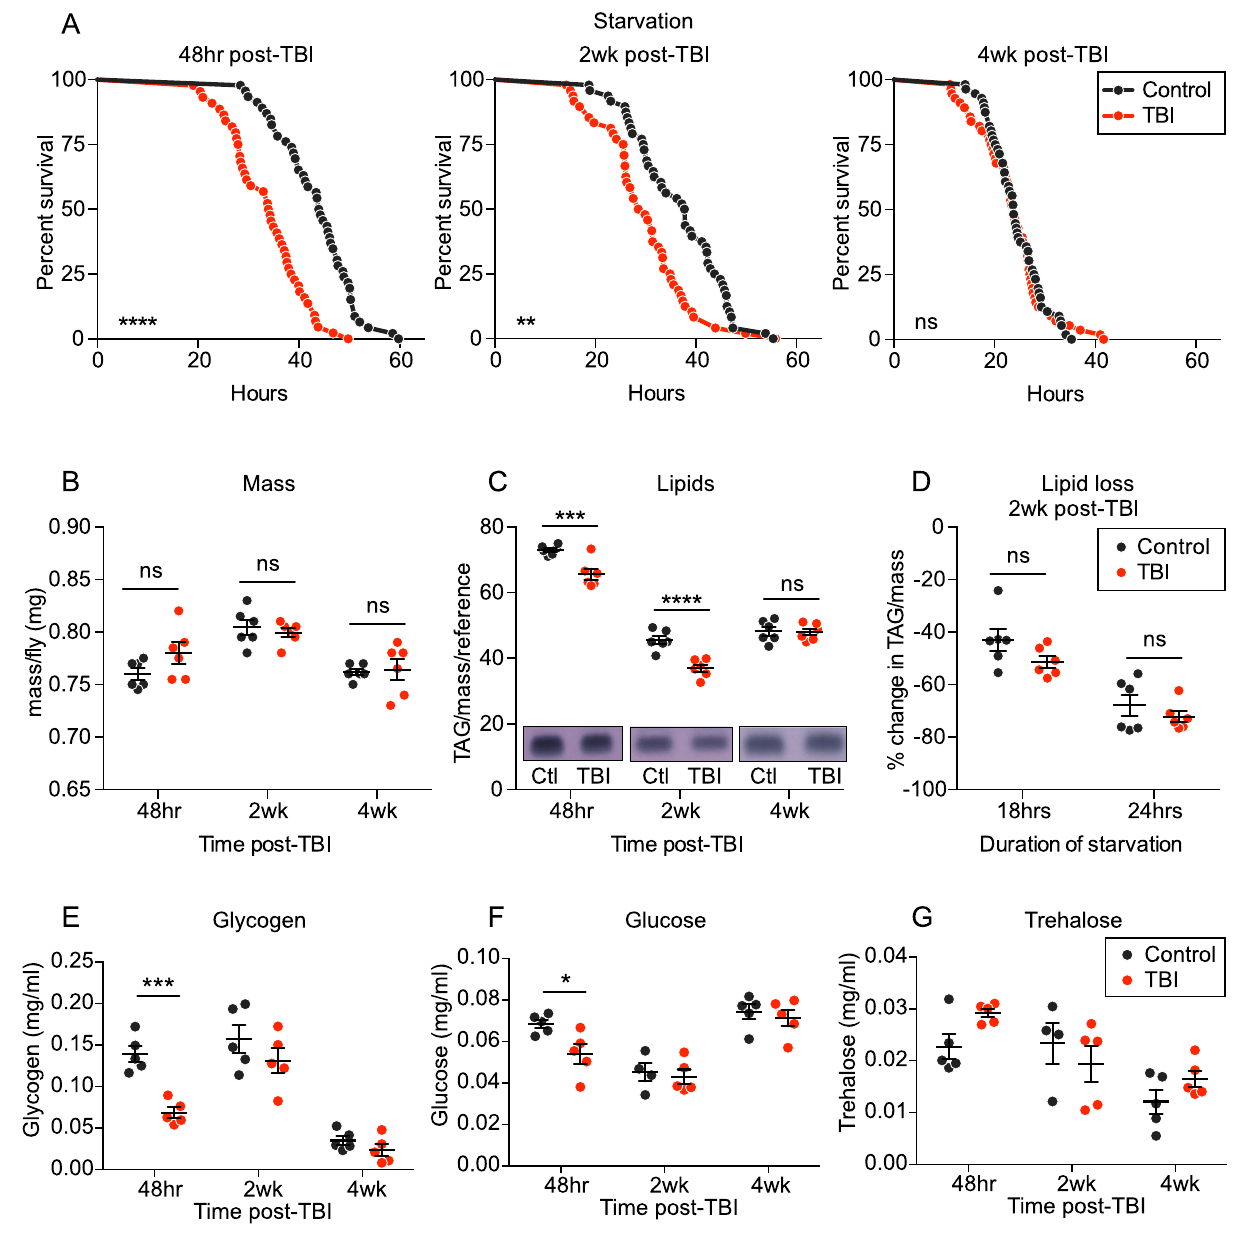
Figure 3. TBI induces metabolic dysfunction that disappears between 2 and 4 weeks following TBI. TBI-treated flies = red; age-matched, uninjured control flies = dark grey. ( A ) TBI-treated flies die faster under starvation than age-matched, uninjured controls at 48 h ( p < 0.0001) and 2 weeks ( p < 0.01) post-TBI, but not at 4 weeks post-TBI, according to both Log-rank and Gehan-Breslow-Wilcoxon survival comparison tests. Representative survival curves shown (44–50 flies per condition); at least three independent replicates were performed yielding similar results. ( B ) Mass is unchanged following TBI, according to a two-way ANOVA, with Sidak’s multiple comparison correction (six replicates of 20 flies each per group). ( C ) TBI-treated flies display lower lipid stores (triacylglycerides, TAG) at 48 h ( p < 0.001) and 2 weeks ( p < 0.0001) post-TBI, but not at 4 weeks post-TBI, according to two-way ANOVA, with Sidak’s multiple comparison correction. Lipids were extracted from TBI- treated and age-matched control flies (six replicates of 20 flies each per group) and measured in triplicate with thin-layer chromatography (TLC) and amido black stain (representative images shown), normalized to mass of individual sample and a reference sample of pure coconut oil, which was included on all TLC plates as a standard. ( D ) TBI-treated flies at 2 weeks post-TBI do not display an increased rate of lipid utilization during starvation. TBI-treated flies display similar reductions in lipid amount after 18 h and 24 h of starvation, as their age-matched, uninjured control flies, according to two-way ANOVA, with Sidak’s multiple comparison correction (six replicates of 20 flies each per group). TBI leads to short-term mobilization of carbohydrates, but returns to normal levels by 2 weeks. ( E ) Glycogen and ( F ) Glucose levels are significantly decreased ( p < 0.001 and < 0.05, respectively) in TBI-treated flies relative to controls at 48 h post-TBI, but not at 2 or 4 weeks post- TBI. ( G ) Trehalose levels are not significantly different at any timepoint post-TBI. Significance determined by two-way ANOVAs, with Sidak’s multiple comparison tests, for each